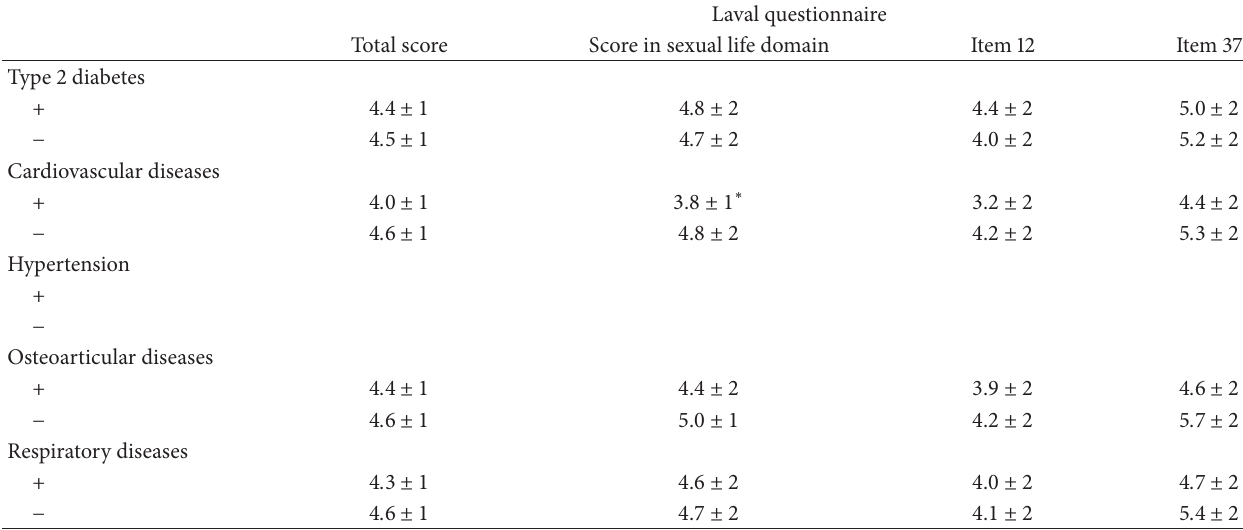
Table 3: Sexual life defined through Laval questionnaire and clinical